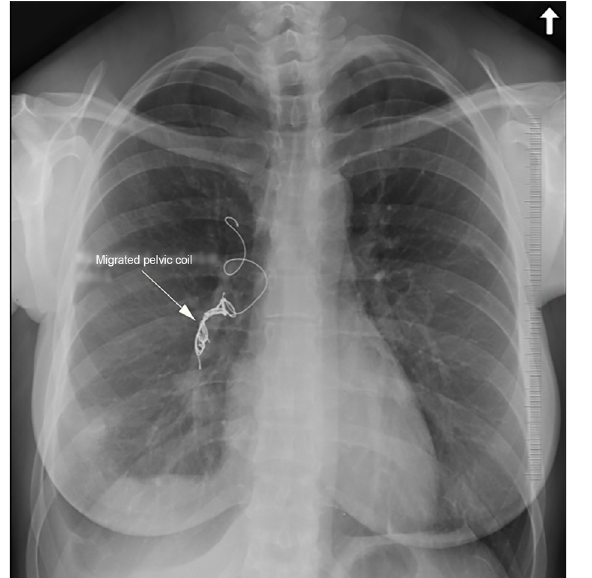
Image 1. Posteroanterior chest radiography showing a migrated pelvic coil (arrow) in the right pulmonary artery extending into segmental branches.